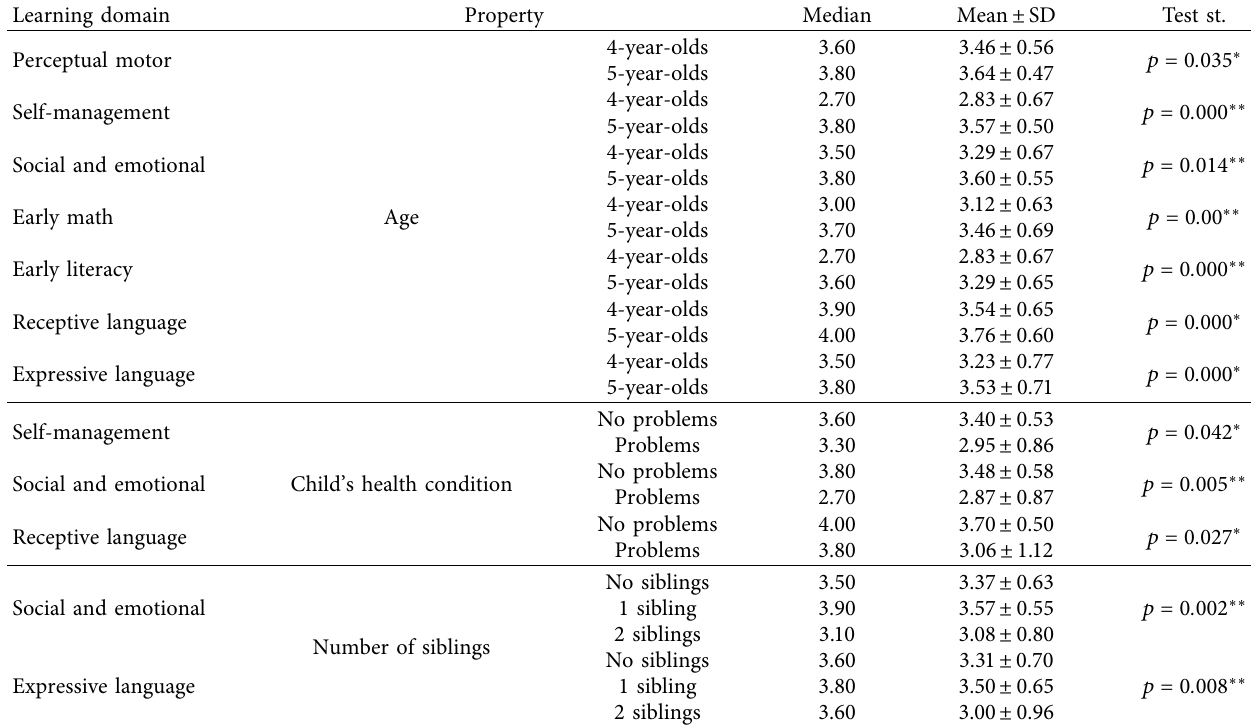
Table 9: Demographic characteristics affecting the ELORS score at significant levels.